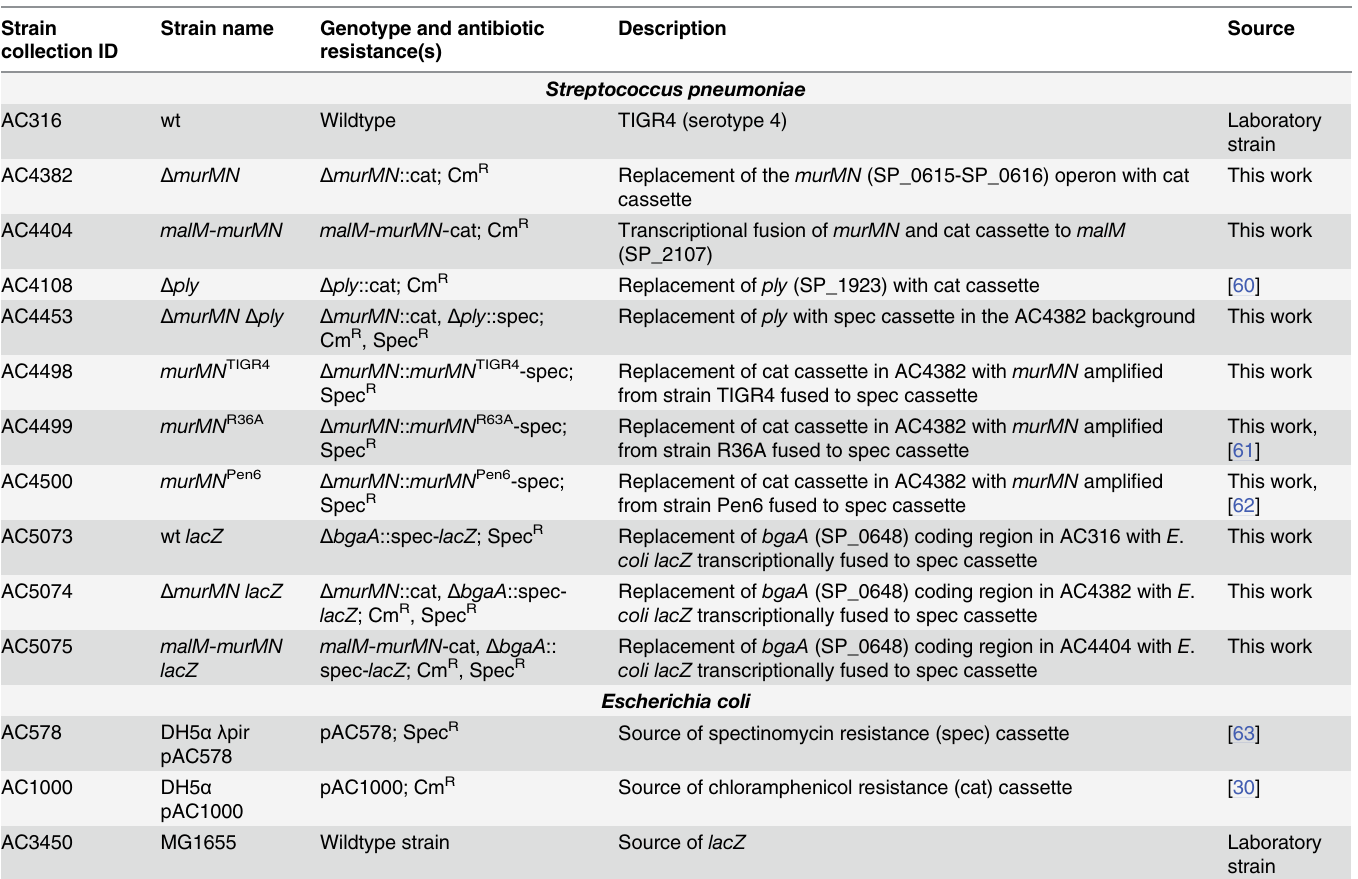
Table 2. Strains and plasmids used in the present